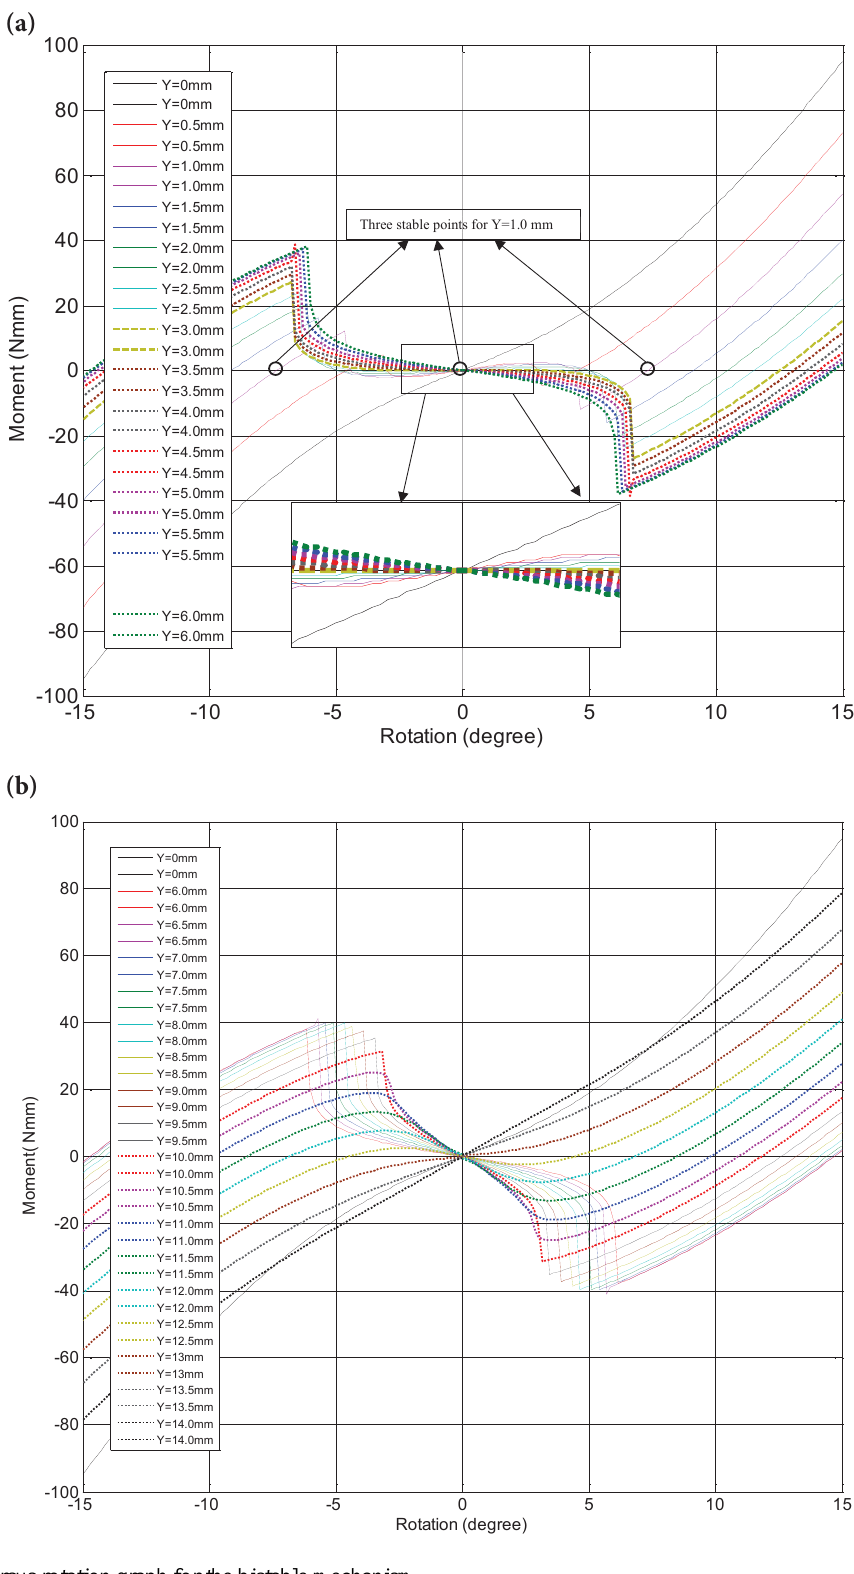
Figure 4. Moment versus rotation graph for the bistable